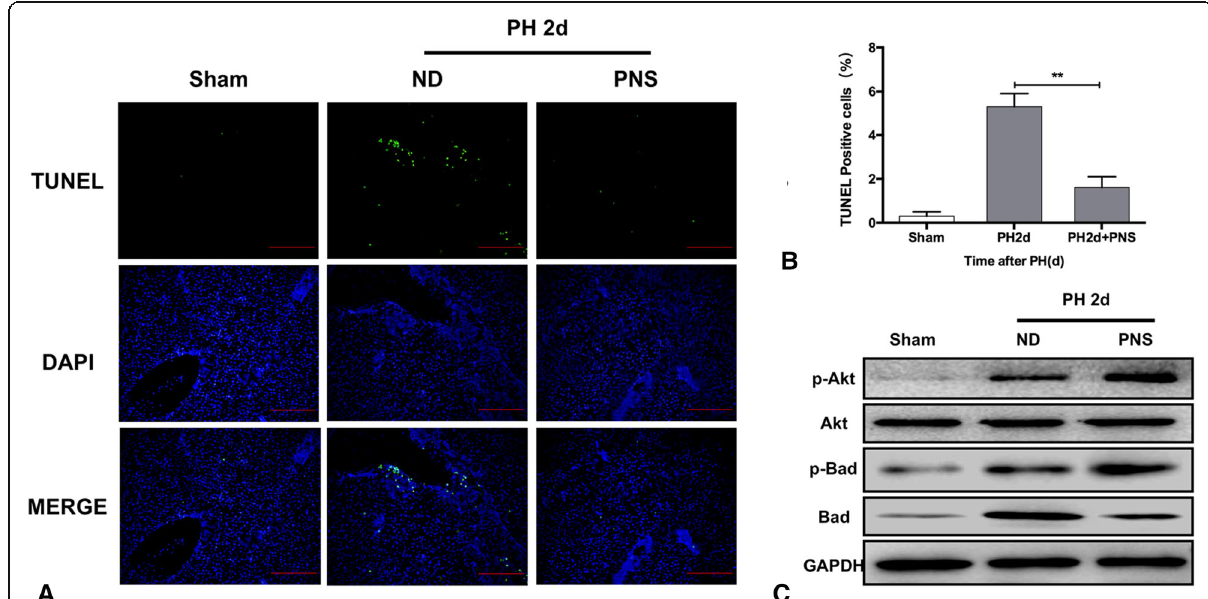
Fig. 3 PNS inhibited cellular apoptosis during LR in vivo via the AKT/Bad pathway. ( a ) Representative liver sections stained by TUNEL in mice treated with or without PNS at 2 d after PH. ( b ) Quantification of TUNEL-positive cells in mice treated with or without PNS at 2 d after PH. ( c ) Total and phosphorylated protein levels of AKT and Bad in mice treated with or without PNS at 2 d after PH. Values represent the mean ± SD of at least three independent experiments; ** P<